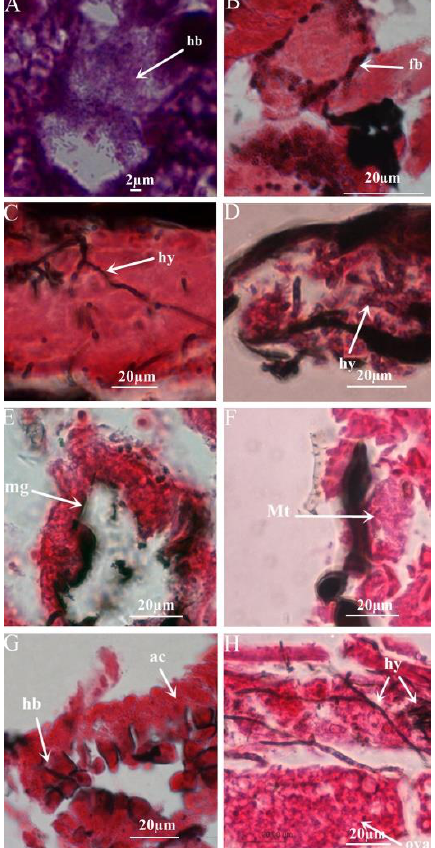
Figure 6. Representative histopathological images of B. bassiana infection of F. occidentalis . ( A ) B. bassiana hyphal bodies (hb) inside F. occidentalis , 12 h p.i., ( B ) fungal hyphal bodies surrounding the insect fat body (fb), 24 h p.i., ( C ) fungal hyphae (hy) in the live insects, 48 h p.i.,